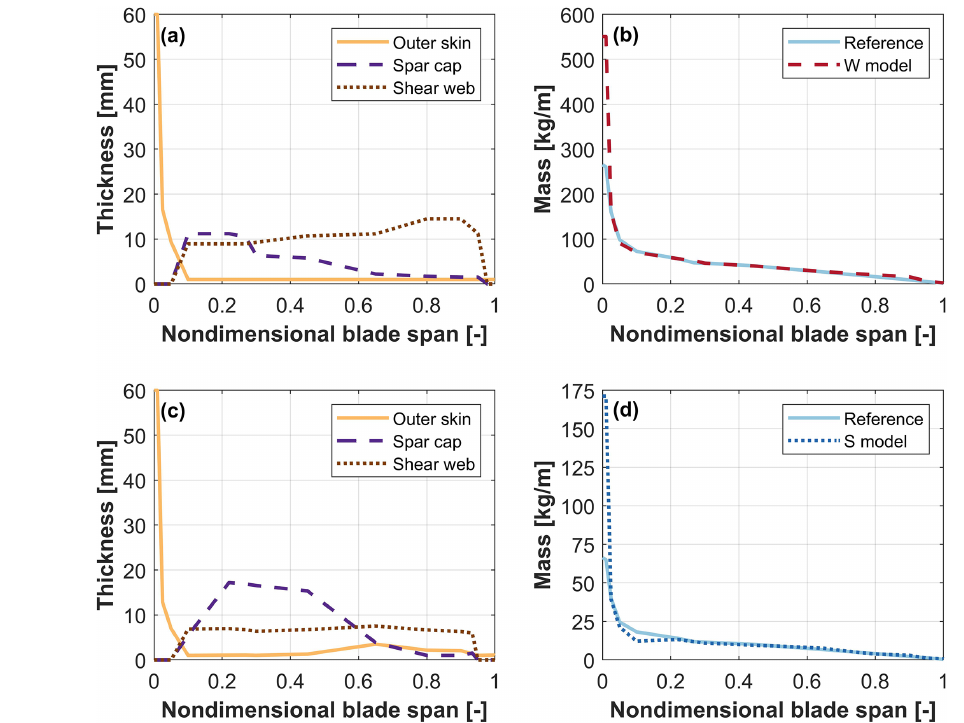
Figure 4. Thickness of the structural components and mass distribution for the W (a, b) and S (c, d) models. The label “reference” indicates the mass distribution of the full-scale blade, subscaled to the W and S